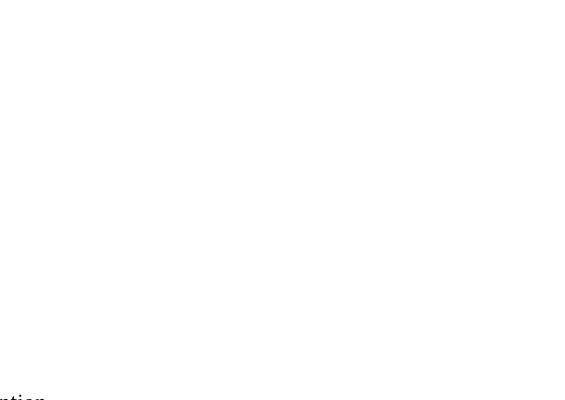
Table 4. Mean illness days per week of